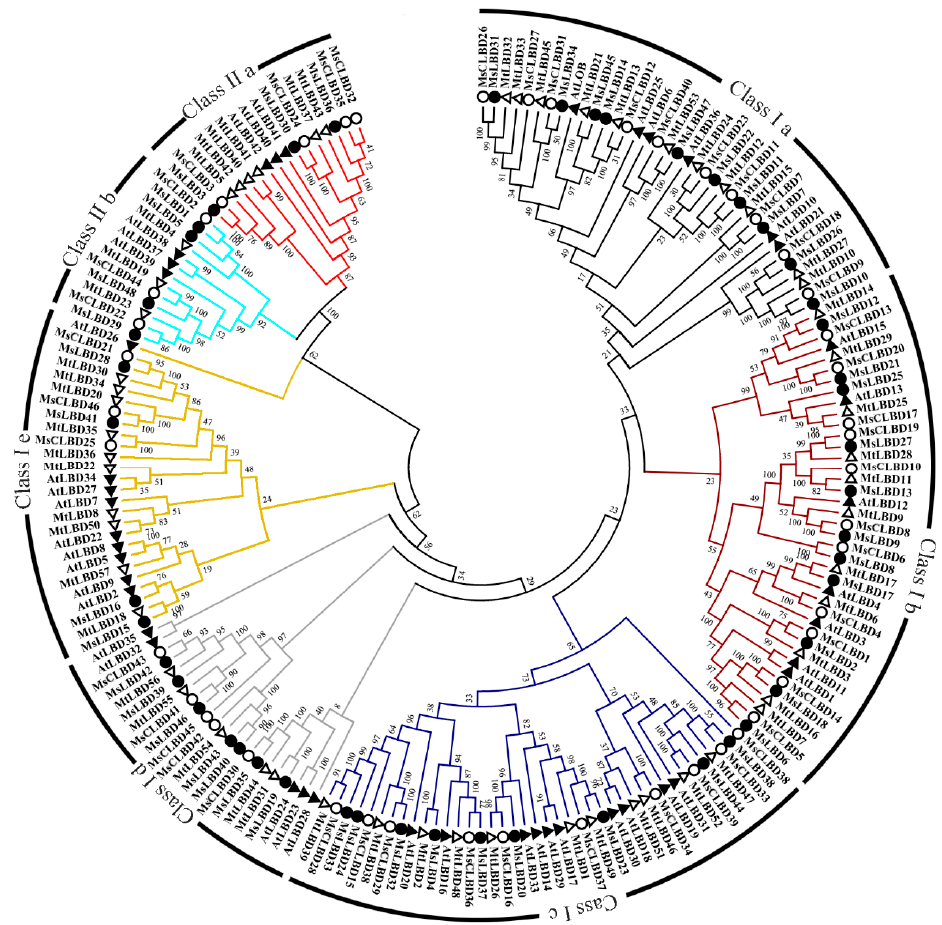
Figure 4. Phylogenetic analysis of LBD proteins in alfalfa, M. sativa spp. Caerulea , M. truncatula and Arabidopsis . The tree was constructed by MEGA6.0 using the neighbor-joining method with 1000 bootstraps. The branch length represents the magnitude of genetic change. Individual LBD subfamily is represented by color.